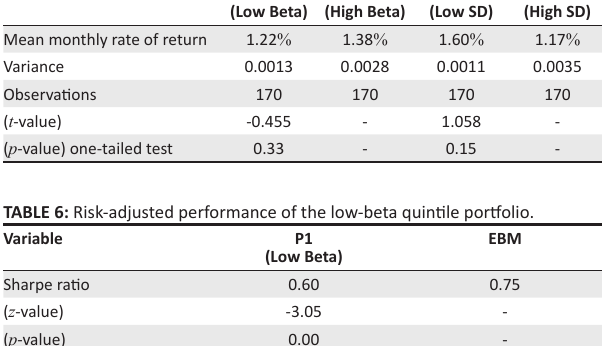
TABLE 5: t -test output for beta and volatility sorted quintile portfolios.